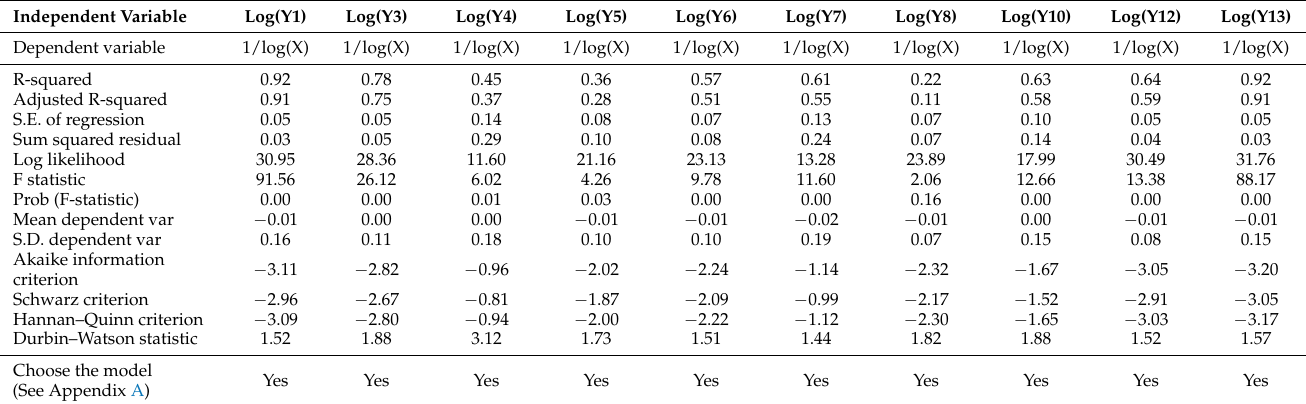
Table 5. Results of the regression (Test